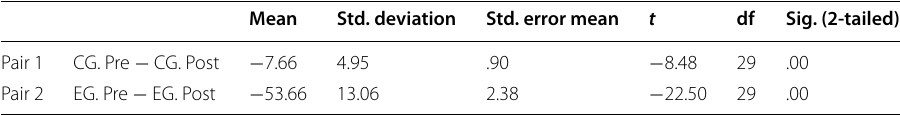
Table 24 Inferential statistics (self‑efficacy post‑test of both groups) Score Equal variances assumed 6.07 .01